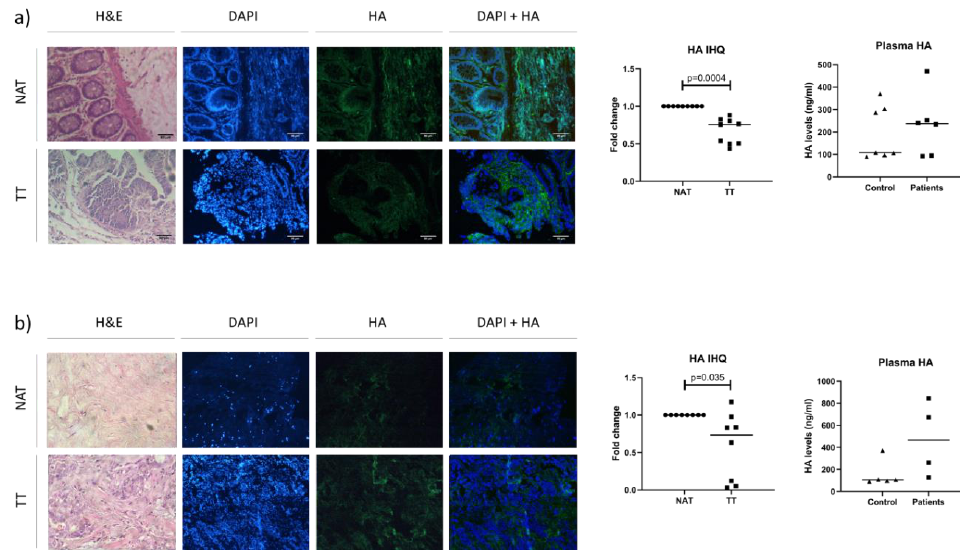
Figure 3. Tissue and plasma HA levels in patients with colorectal and breast cancer. ( a ) Colorectal cancer HA analysis. Representative image of immunohistochemical staining of HA (left) with the graph (middle) and plasma HA analysis of patients and healthy donors by ELISA (right). ( b ) Breast cancer HA analysis. Representative image of immunohistochemical staining of HA (left) with the graph (middle) and plasma HA analysis of patients ( ▪ ) and healthy donors ( ∧ ) by ELISA (right). H&E-hematoxylin and eosin; HA-hyaluronic acid; TT (▪)-tumor tissue; NAT (●)-adjacent non-tumor tissue. Results of immunohistochemistry are expressed as TT relative to NAT. p-values lower than 0.05 were considered statistically significant; Scale bar = 80 µm .